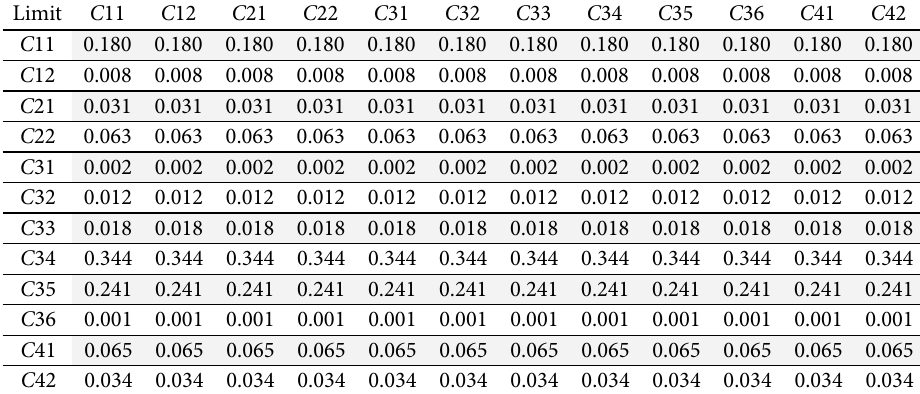
Table 9. Stable matrix of ANP when power lim j → ∞ = ( W α )